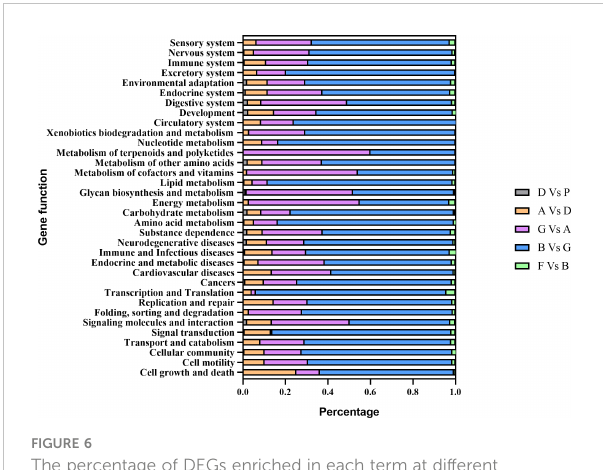
FIGURE 6 The percentage of DEGs enriched in each term at different developmental